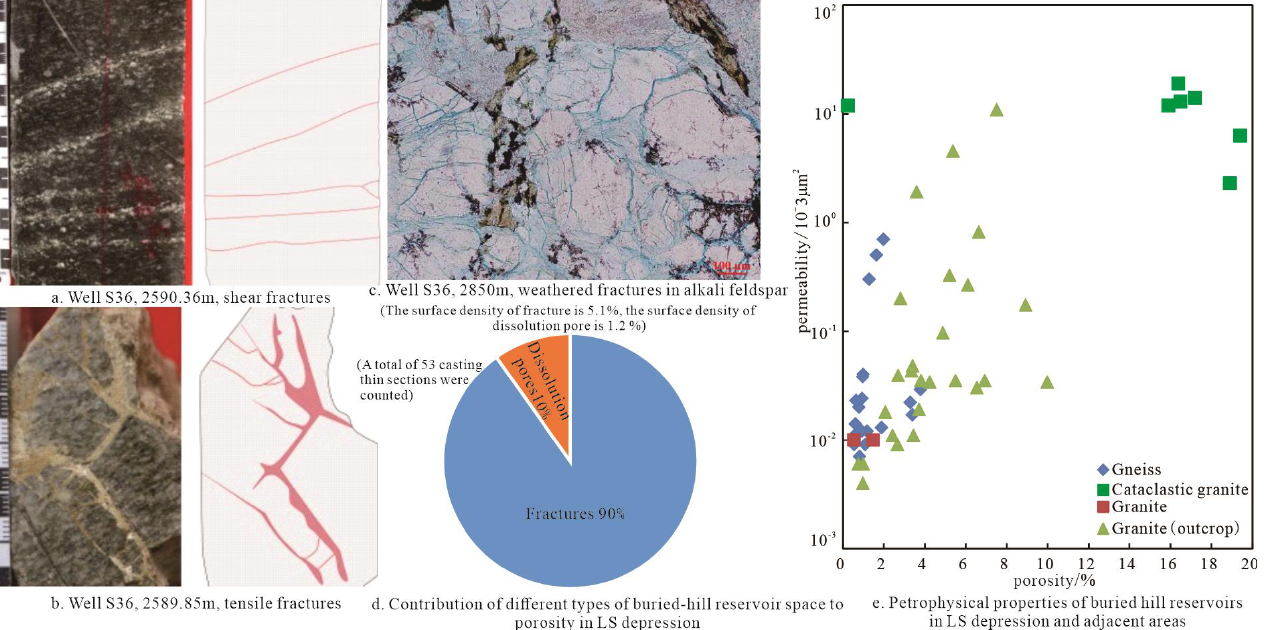
Figure 11. Reservoir characteristics of basement rocks in the LS depression. Note: ( a , b ) show the fracture characteristics of the core of the buried hill in the well S36, ( c ) shows the characteristics of the weathered fractures of the core of the buried hill in the well S36, ( d ) shows the contribution of pores and fractures to the reservoir space of the buried hill, and ( e ) shows the cross plot of the measured porosity versus permeability of granite and gneiss.